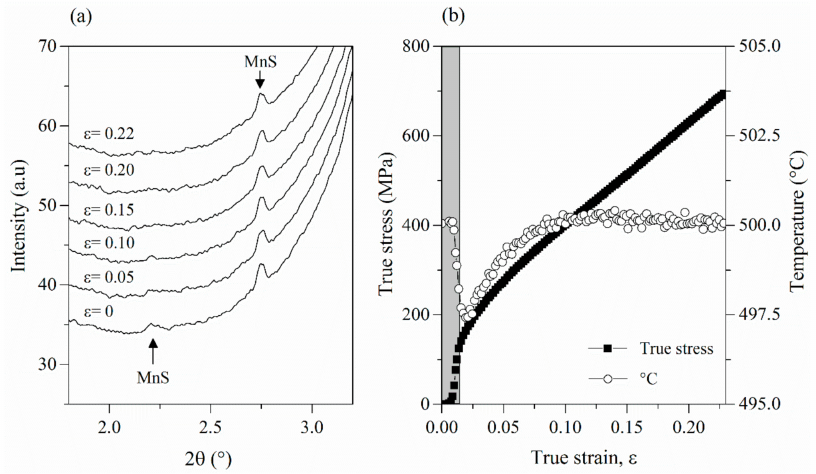
Figure 3. ( a ) Sequence of the integrated diffraction patterns as a function of strain during the dynamic transformation of bainite at 500 ◦ C. The scale was enlarged in the X-axis in the 2 θ range where carbides are expected to appear. The diffraction peaks of manganese sulfide (MnS) are indicated by the arrow. ( b ) Temperature evolution of the sample during deformation. For reference, the true stress curve is also displayed in this figure. The grey shaded area represents the elastic regime of the austenite at 500 ◦